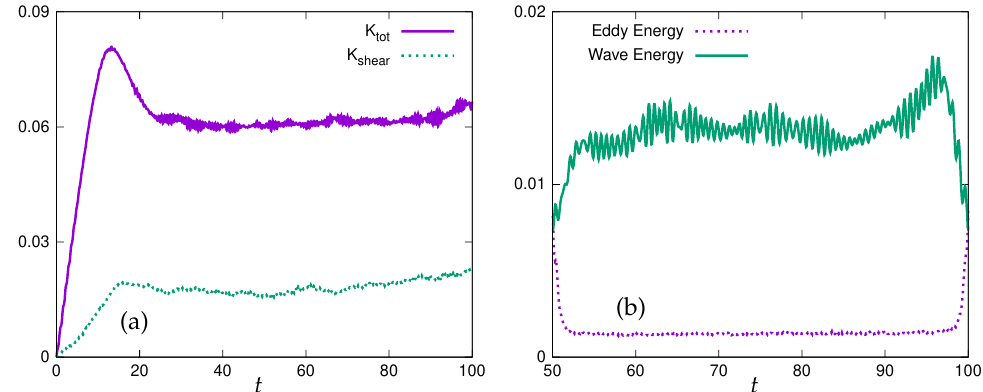
Figure 11. ( a ) Total kinetic energy K tot and kinetic energy of the shear mode K shear against time. ( b ) Evolution of the wave part of the vertical kinetic energy E (cid:63) , w z and of its eddy part E (cid:63) , e z